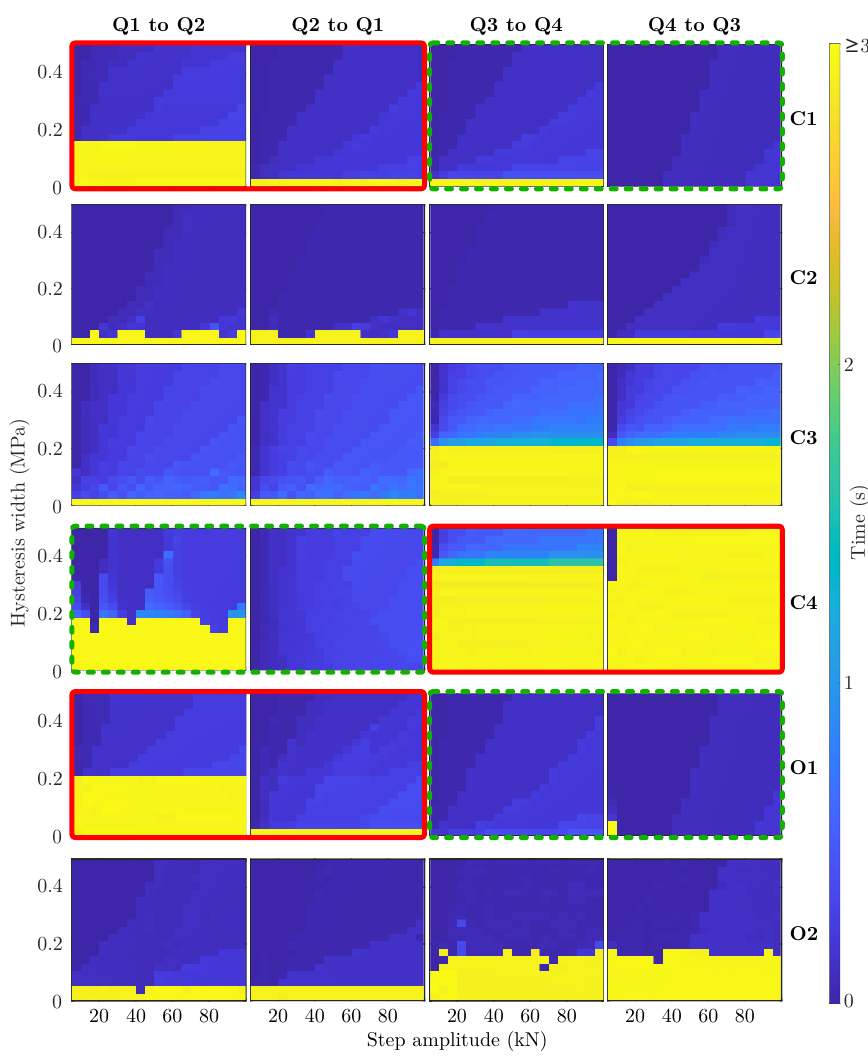
Figure 16. Same as Figure 15 but with slow motor